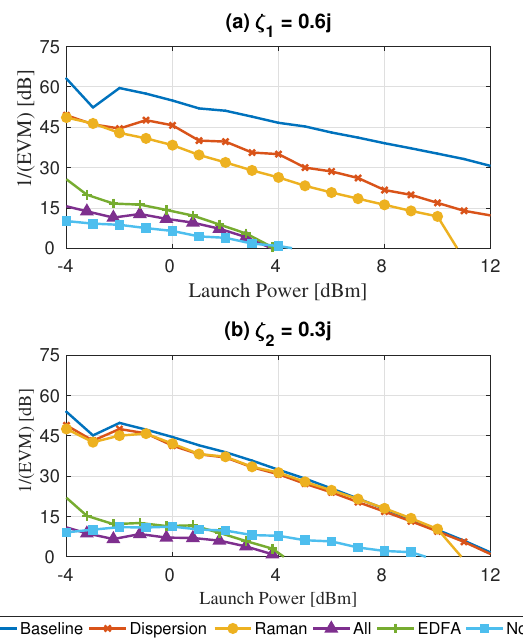
Figure 14. The reciprocal of the EVM as a function of the launch power when all the effects are included and the symbol period is equal to T S1 . ( a ) Results of the signal that is decoded from the first eigenvalue ζ 1 = 0.6 j . ( b ) Results of the signal that is decoded from the second eigenvalue ζ 2 = 0.3 j .